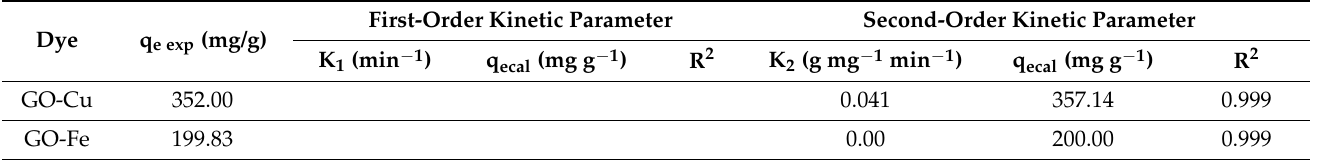
Table 2. Pseudo-first-order and pseudo-second-order kinetic model parameters for adsorption